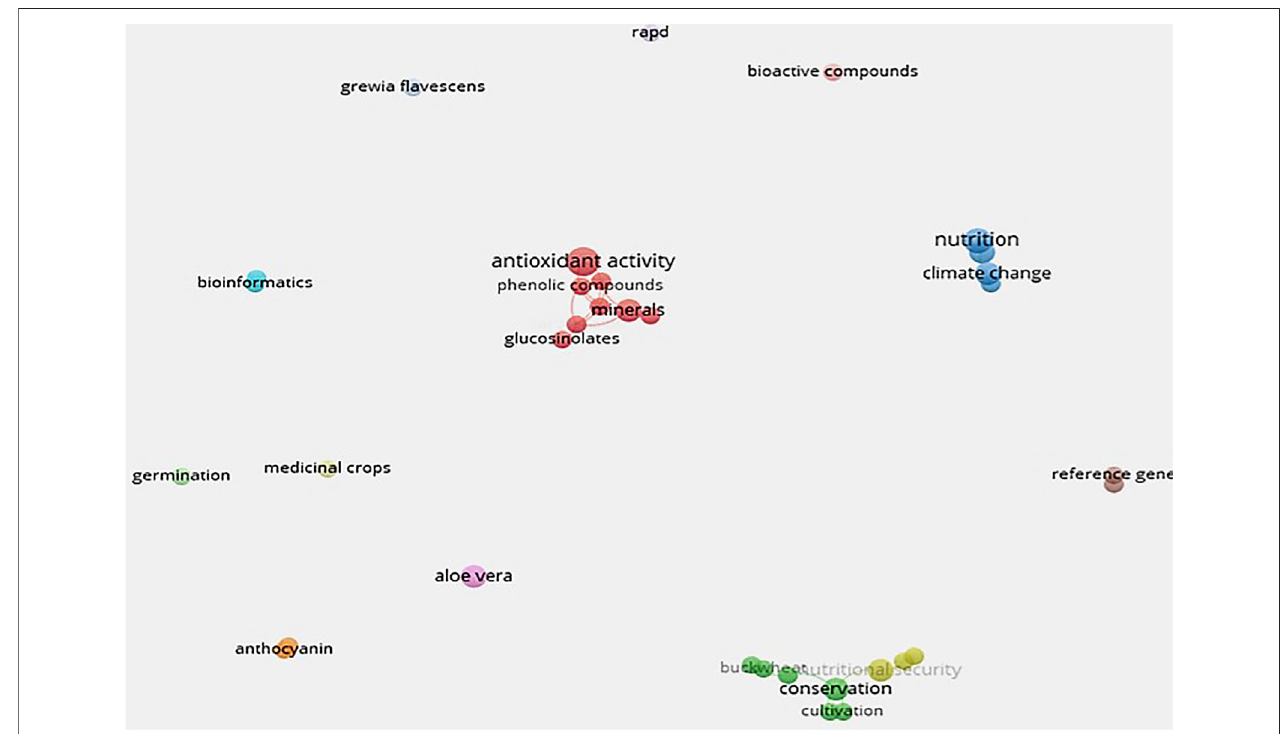
FIGURE 3 | Topical concepts on neglected and underutilised functional medicinal crops (NUFMS) derived using data from titles and abstracts in VosViewer.